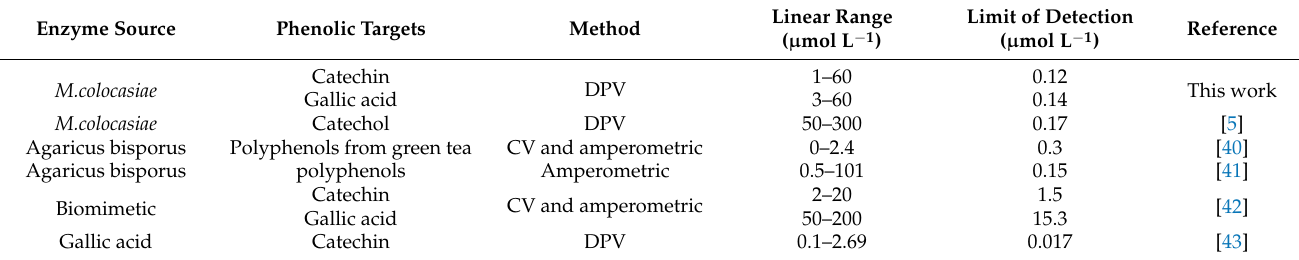
Table 3. Comparison of the results obtained with the biosensor developed in this research with other immobilized polyphenol oxidases electrodes for the detection of catechin, gallic acid, and phenolic compounds in green tea samples. Enzyme Source